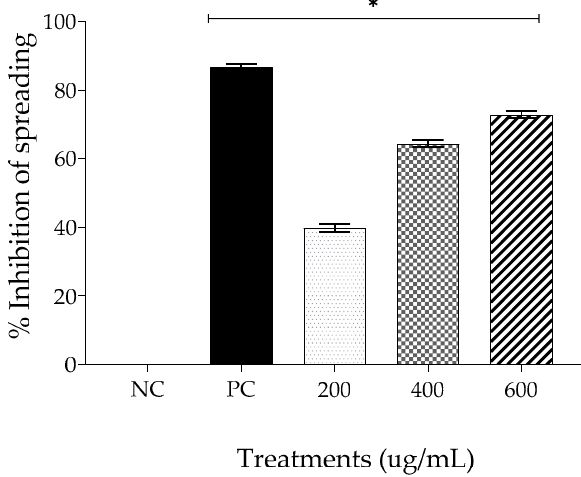
Figure 5. Mean ± SD of inhibition of spreading for each treatment group: negative control (NC; physiologic solution 0.9%), positive control (PC; 100 µ g/mL, dexamethasone), and EPPR (200 µ g/mL, 400 µ g/mL, and 600 µ g/mL). The asterisk (*) indicates a significant difference ( p < 0.05) compared with the NC. One-way ANOVA followed by Tukey’s post hoc test.